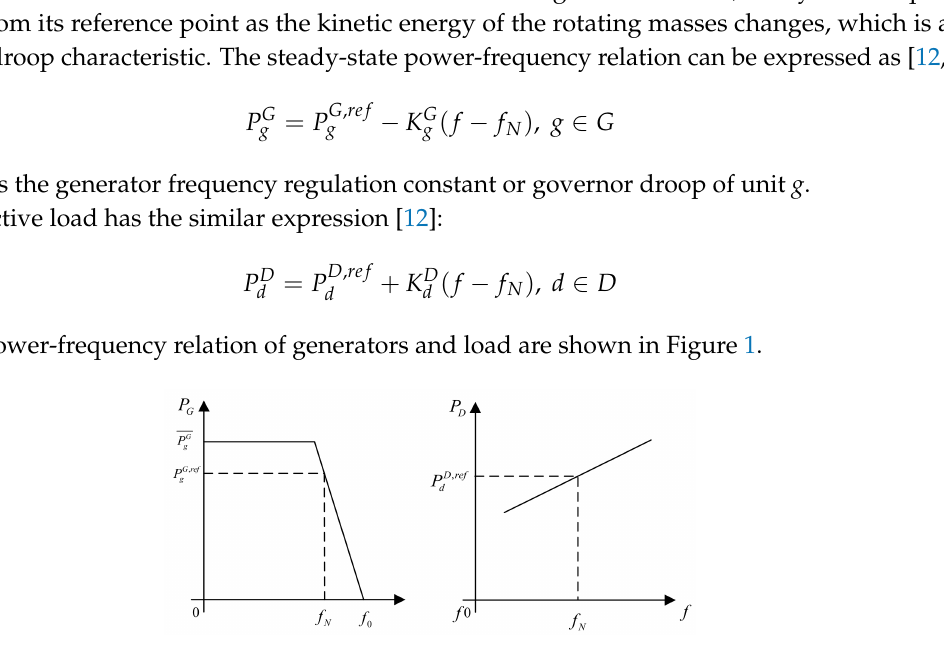
Figure 1. Power-frequency relation of generators and